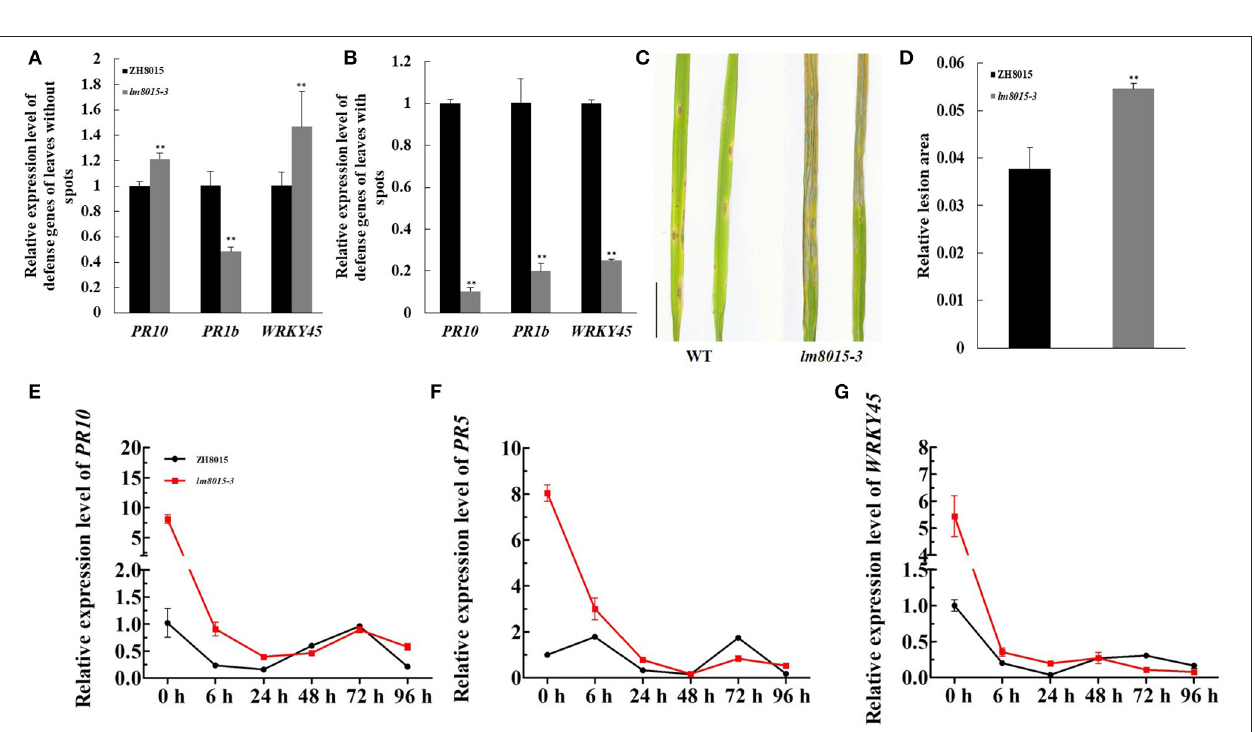
FIGURE 4 | Map-based cloning of lm8015-3. (A) LM8015-3 was first mapped on chromosome 12 between markers 12–18 and RM27956 with 96 F 2 individuals. (B) LM8015-3 was finally mapped between markers C35-16 and W35-6 with 1,251 F 2 individuals. (C) A single base substitution (T to A) occurred in the first exon of LOC_Os12g16720 resulting in the mutation of Val to Asp. (D) The knockout plant of LOC_Os12g16720 in Nipponbare showed the same phenotype with lm8015-3 .